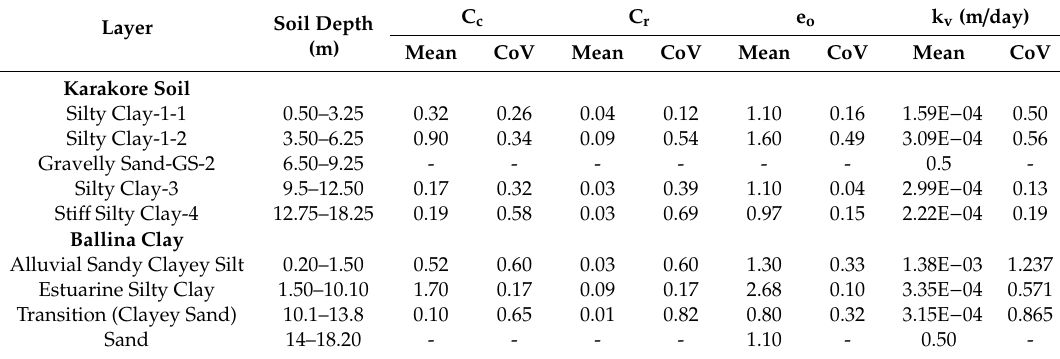
Table 1. Compression and hydraulic parameters of two soft soils (laboratory test